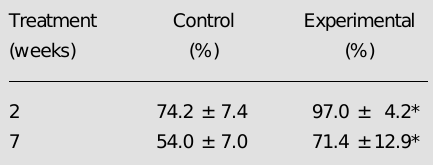
Table 1a - Reduction of thiobarbituric acid reactant